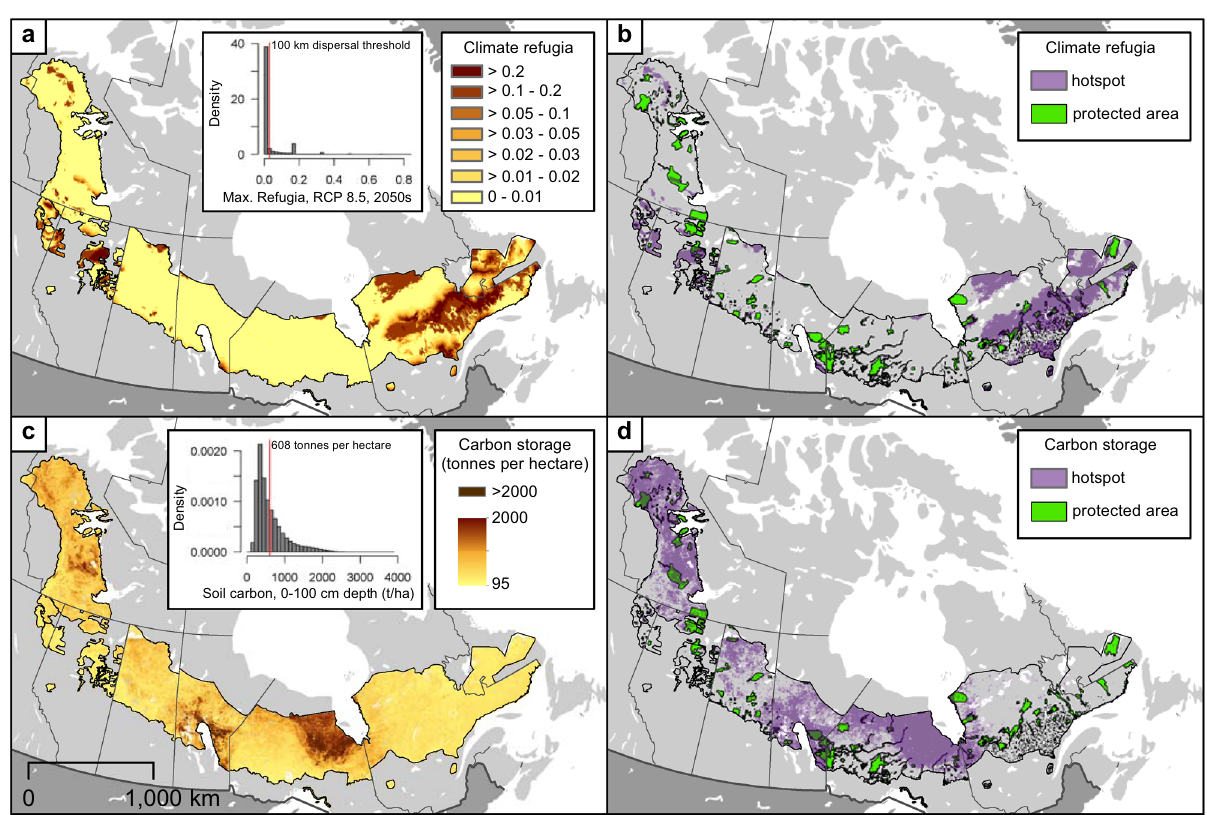
Figure 3. Spatial distribution of raw values (left column) and hotspots (right column) for ( a – b ) climate refugia; and ( c – d ) soil carbon storage across the distribution of boreal caribou. Climate refugia hotspots identified using a dispersal threshold of 100 km/century. Soil carbon storage hotspots identified as ≥ 608 tonnes/ha.